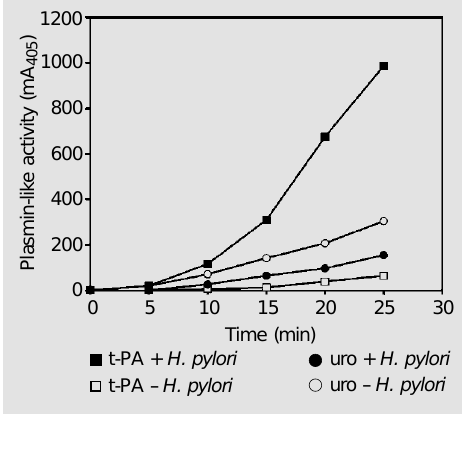
Figure 4 - Effect of cell density on t-PA-catalyzed plasminogen activation. Plasminogen (1.5 µM)